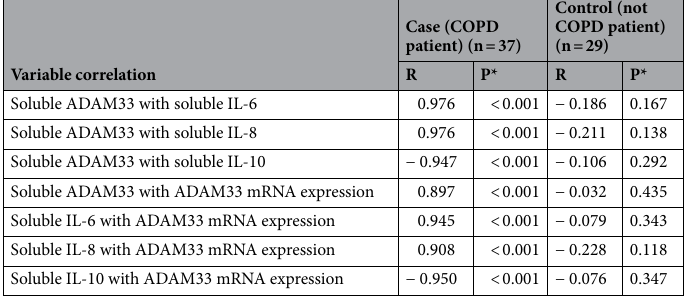
Table 6. Correlation between soluble cytokines levels (IL-6, IL-8 dan IL-10) and ADAM33 *Spearman correlation.